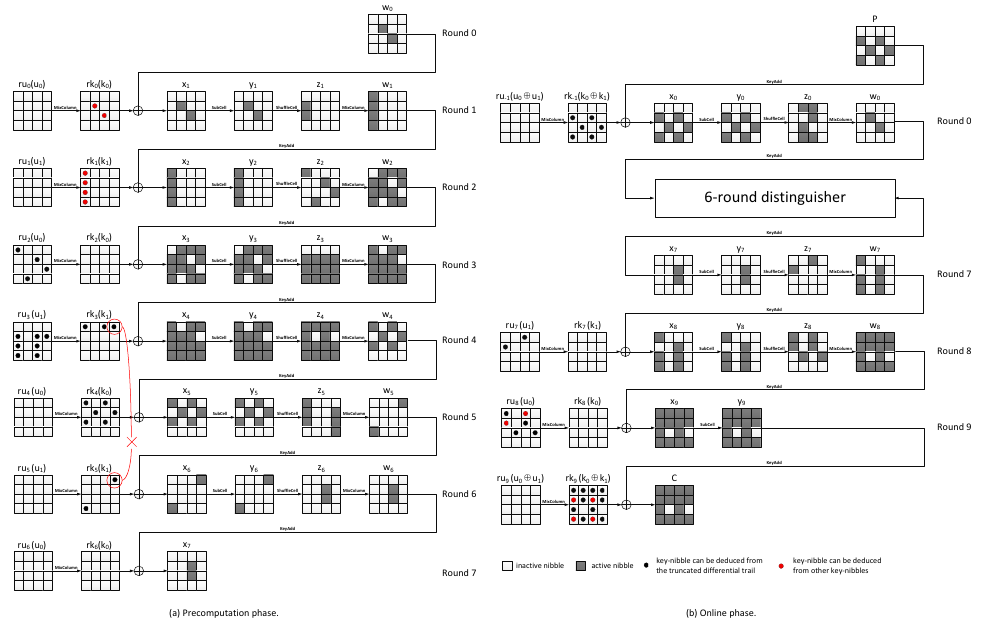
Figure 6: The attack on 10-round Midori64. The 6-round distinguisher is shown in (a), the online phase is shown in